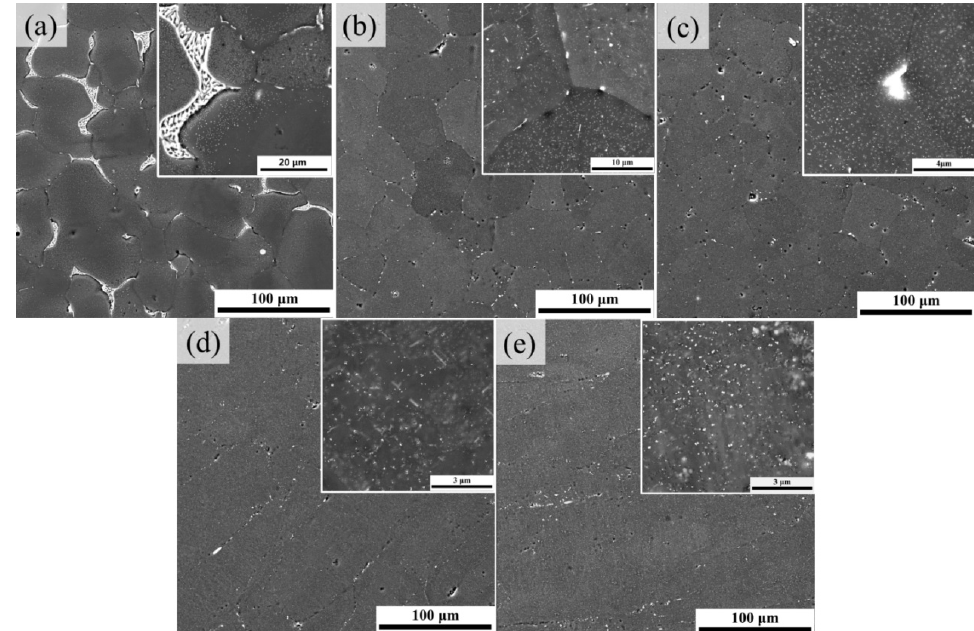
Figure 3. BSE images of the ( a ) as-cast state, ( b ) solutionized state, ( c ) T6 state, ( d ) P70A-120 state and ( e ) P80A-120 state.